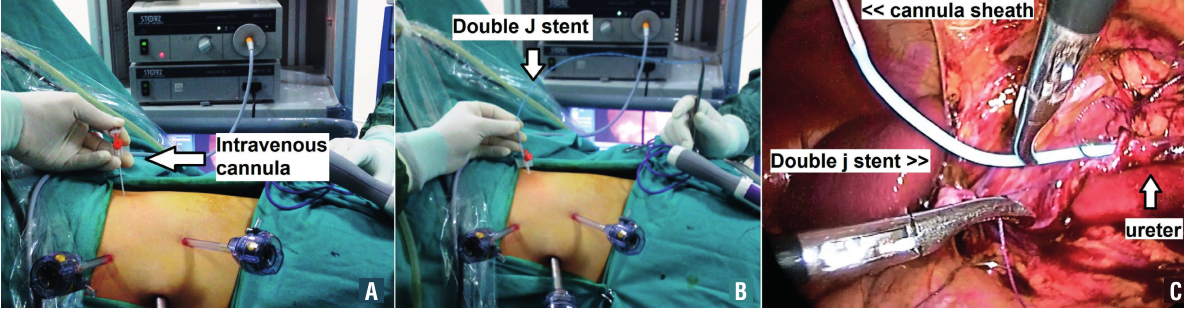
Figure 1 - (A) Iv cannula (14G) is performed from a suitable location. (B) The assembled stent is advanced from inside the Iv cannula sheath. (c) Under laparoscopic imaging the stent is gently grasped at its distal end to insert it into the ureter.